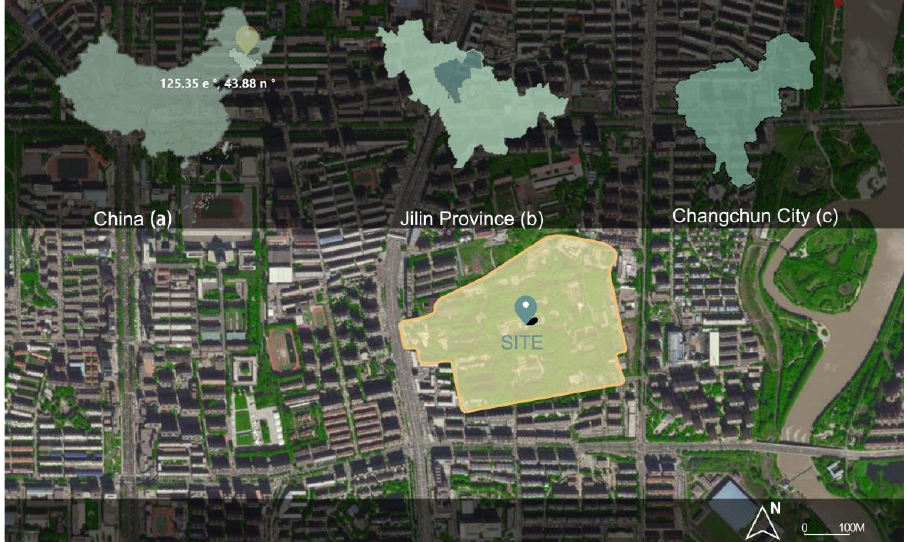
Figure 1. Location and scope of the